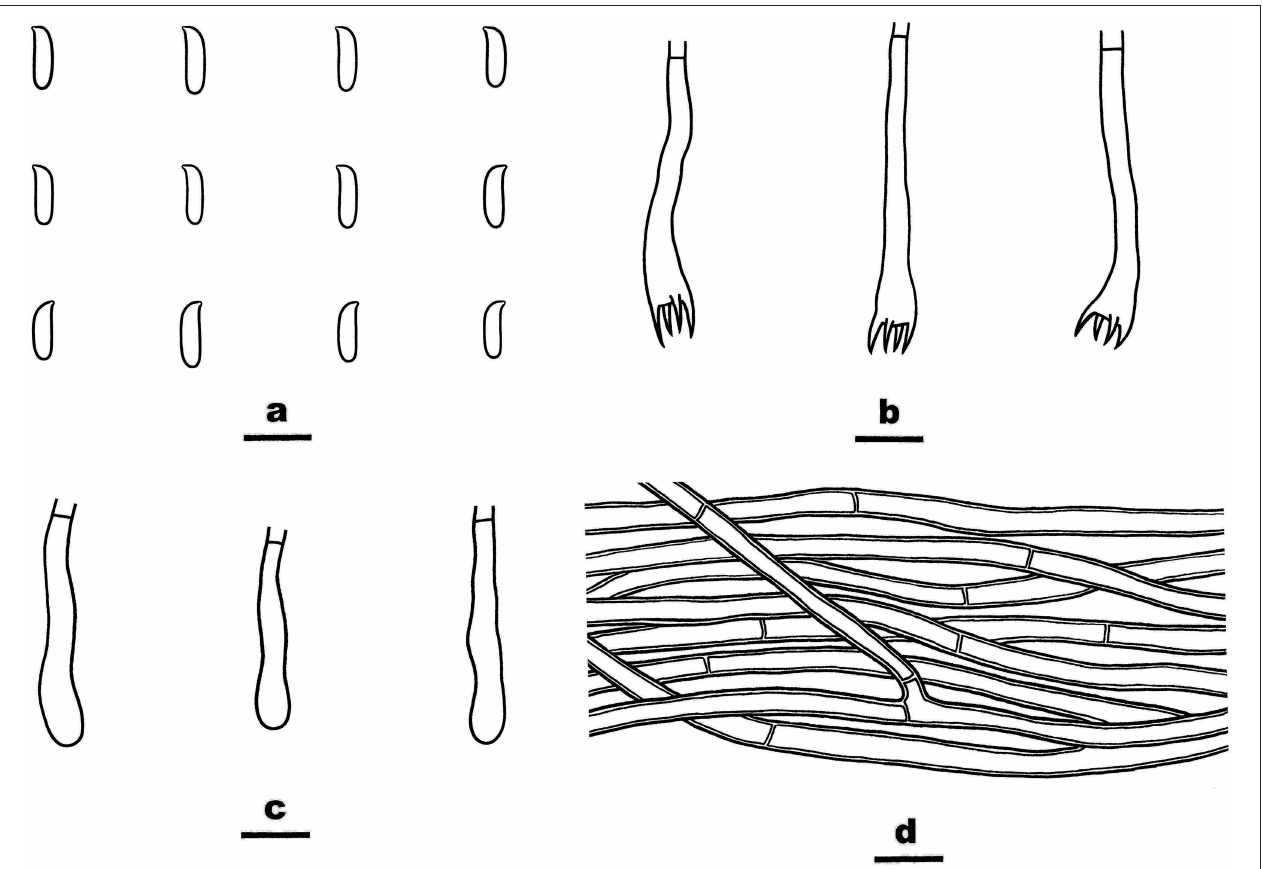
FIGURE 13 | Phanerochaetella queletii (from He 3284; scale bars: a–d = 10 µ m). (A) Basidiospores. (B) Basidia. (C) Basidioles. (D) Hyphae from subiculum.